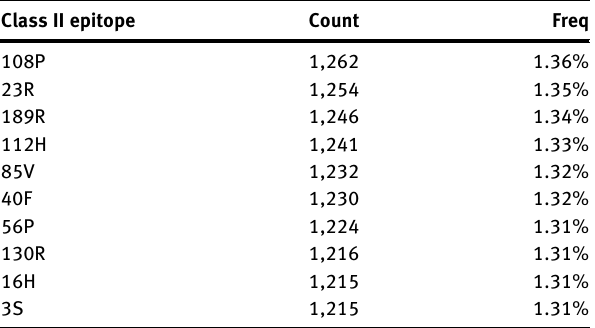
Table  : Class II epitope frequencies. Class II epitope